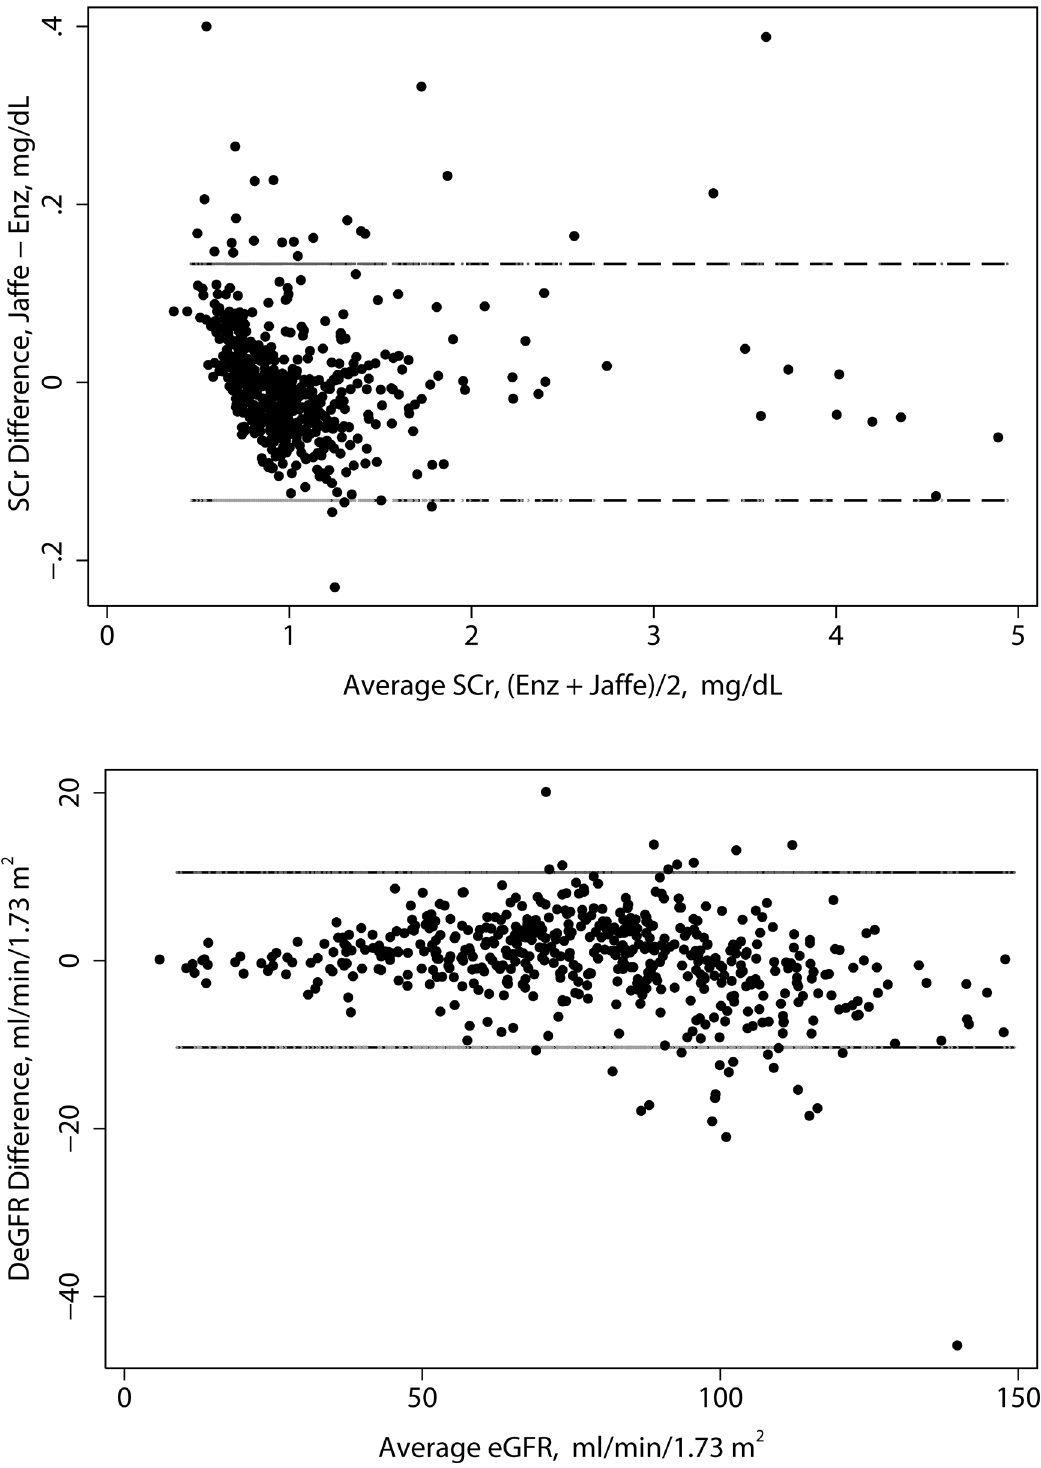
Fig 4. Bland-Altman plots for creatinine and eGFR. Upper panel: Creatinine. Lower panel: eGFR.